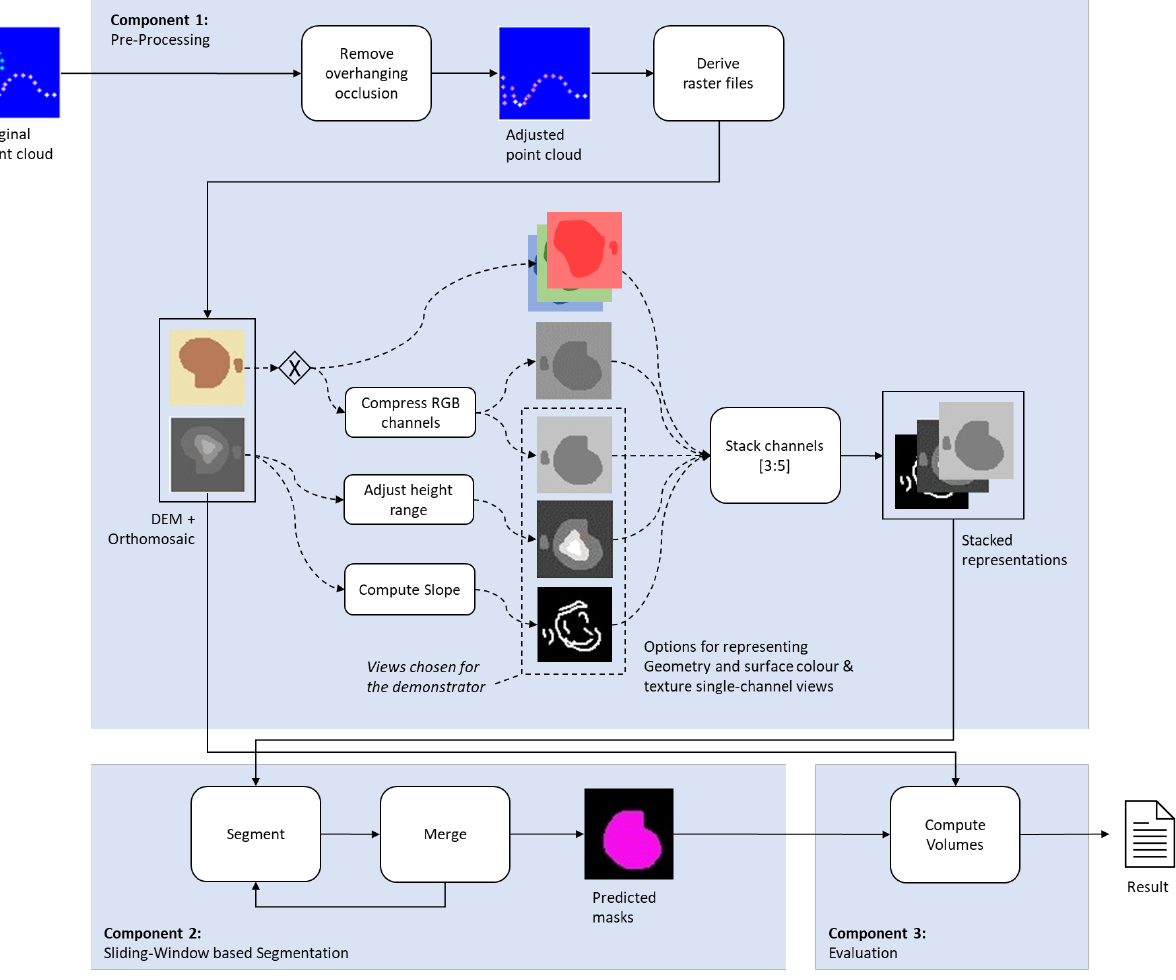
Figure 6. Proposed pipeline; schematic.